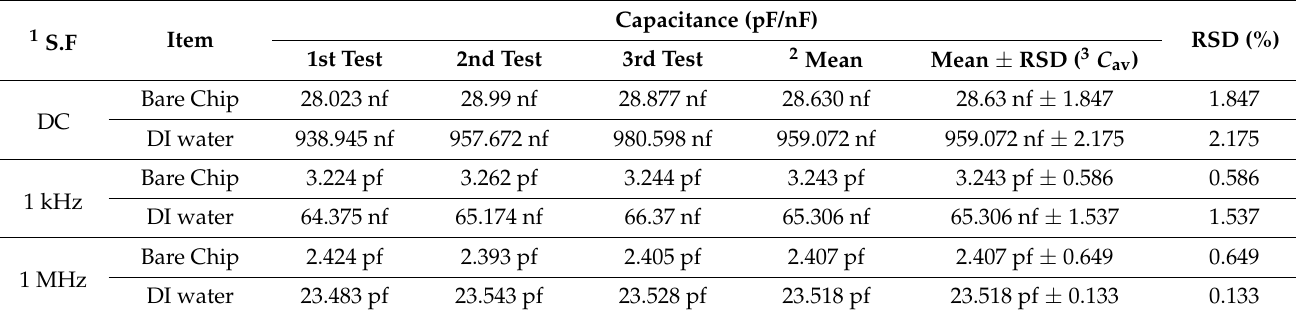
Table 1. Performances of the different measured capacitance for the bare chip and under DI water for the PDMS cavity-based DC/1 kHz/1 MHz capacitor-based biosensor .